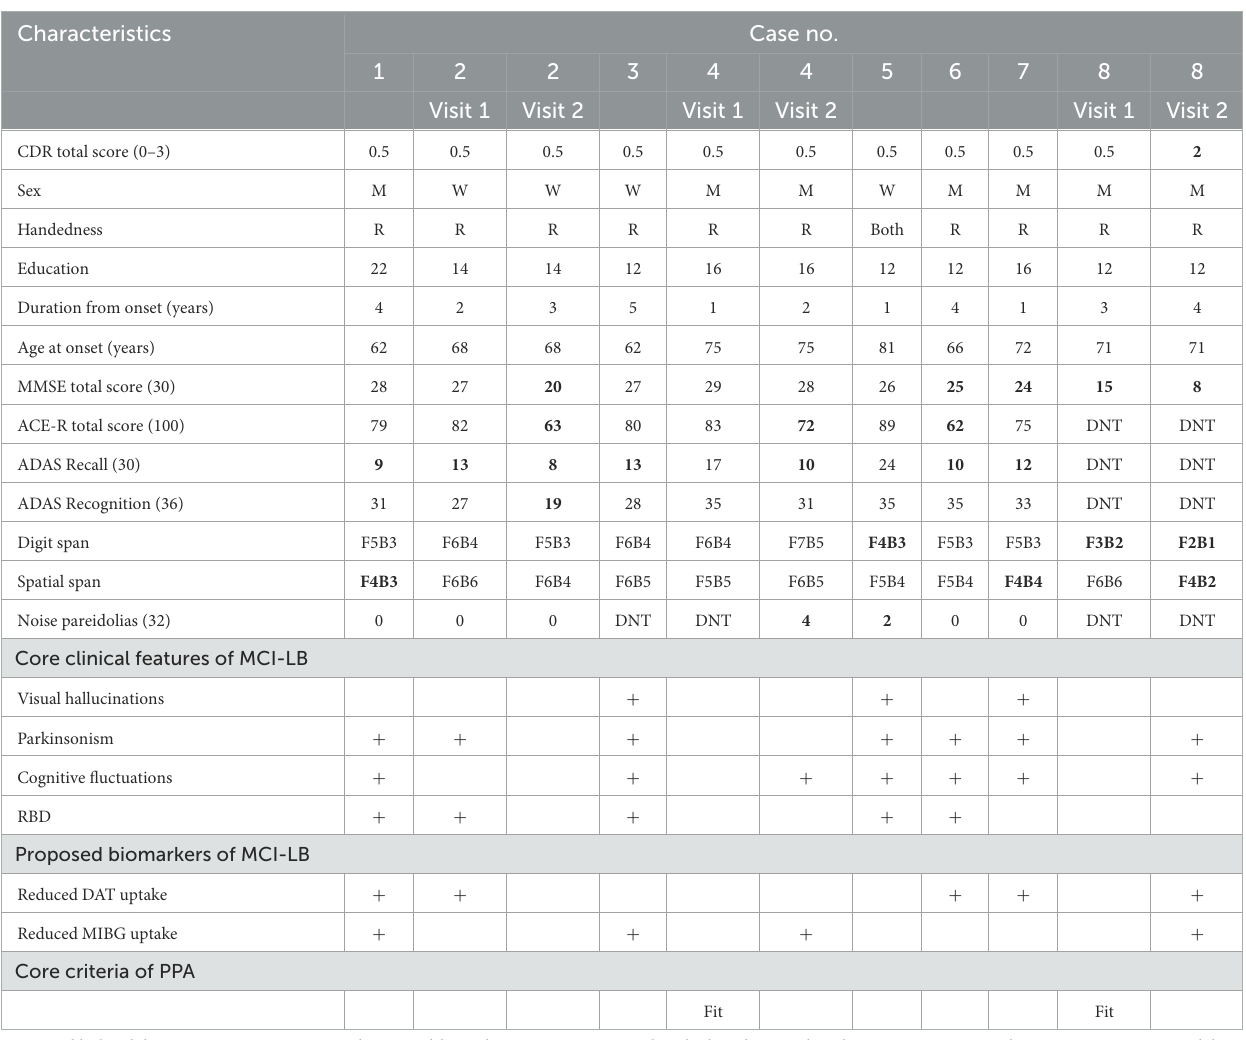
TABLE 1 Demographics and characteristics of patients with MCI-LB.